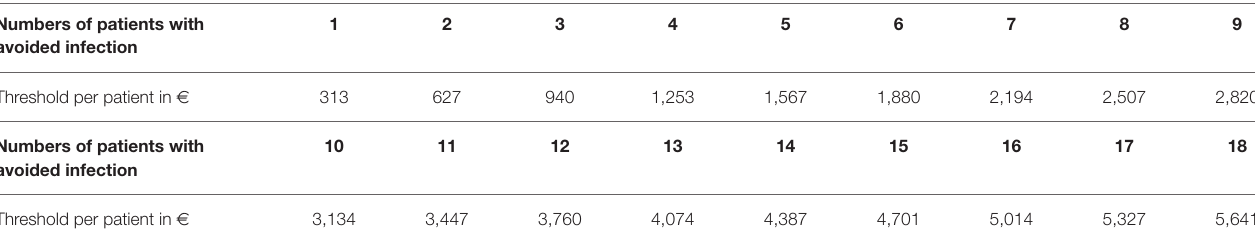
Numbers of patients with avoided